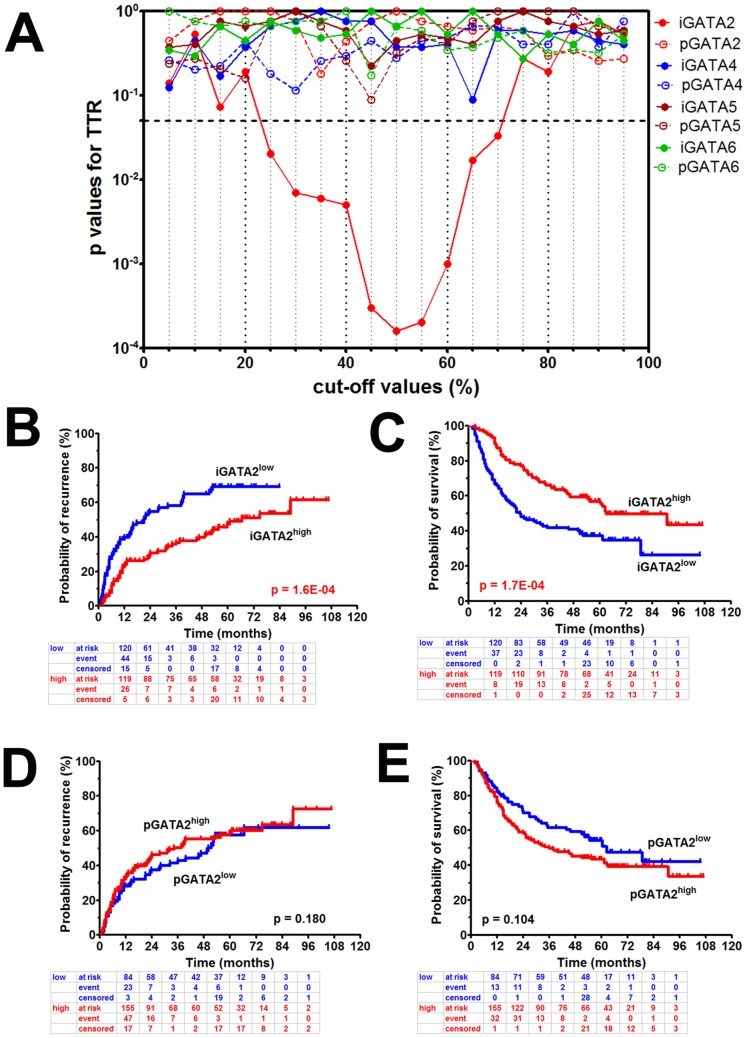
Minimum p values of GATA proteins (A) for recurrence and Kaplan-Meier analyses of GATA2 for recurrence (B, D) and death (C, E).Cut-off values of intratumoral GATA2 reaching statistical significance ranged from 25% to 70% (A, dashed line indicated p = 0.05). Decreased intratumoral GATA2 expression (blue line) significantly correlated with increased recurrence rate (B) and decreased overall survival (C). Frequencies of patients at risk, event or censored were created by life table method. High and low subgroups were defined by optimal cut-off using minimum p value approach.